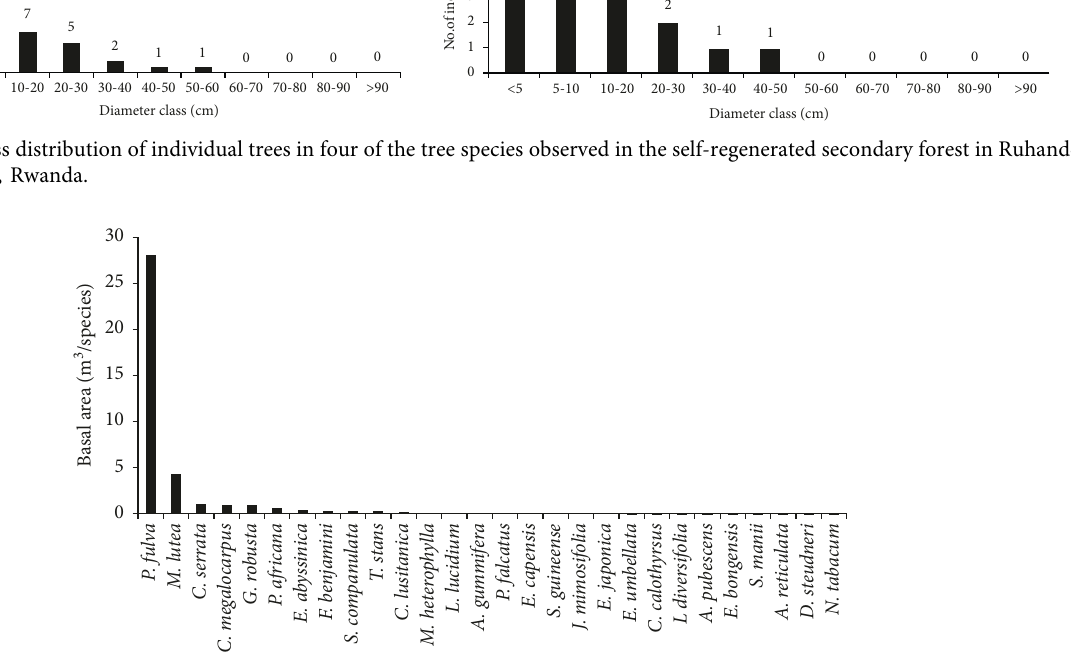
Figure 9: Basal area across all plots per woody species measured in the self-regenerated secondary forest in Ruhande Arboretum, Huye, Rwanda.